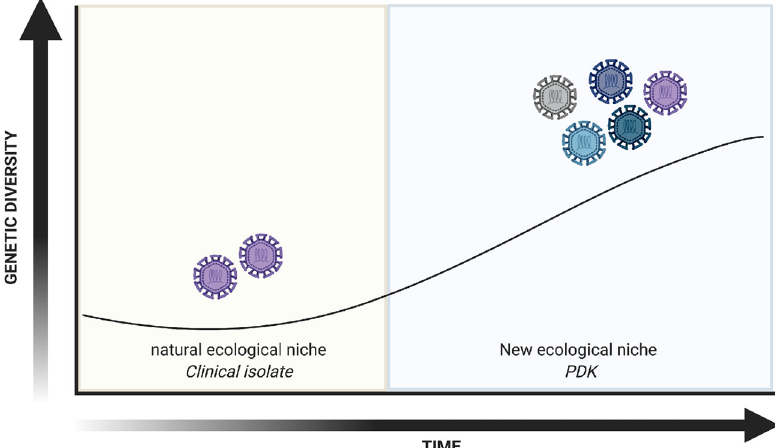
Fig. 4 Hypothetical diagram of changes in dengue genome diversity. As dengue circulates in its natural ecological niche, the virus undergoes selection pressures imposed by the alternating human host and mosquito vector. When the virus is transferred to a new ecological niche in vitro and continually passaged, the past selective pressures of host and vector are replaced with those of the new niche. Images are created using